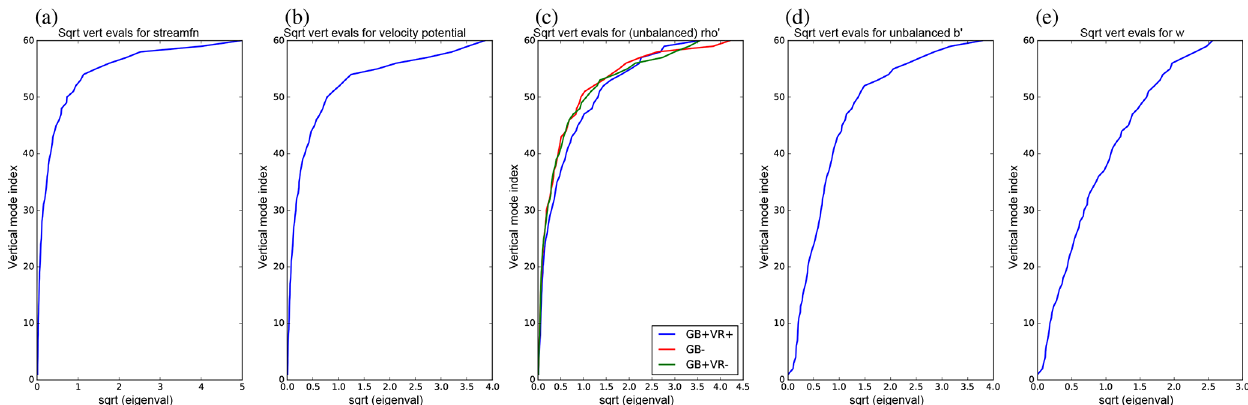
Figure 4. Profiles of the square root of the vertical eigenvalues for the five control parameters as a function of vertical mode index ν : (a) δ ψ , ˜ ρ (cid:48) u , (d) δ b (cid:48) u , and (e) δ w . The blue lines are for the experiment described in the text – namely GB and VR switched on. In (b) δ χ vp , (c) δ panel (c) the red line is for the experiment with GB (and hence VR) switched off, and the green line is for the experiment with GB switched on and VR switched off. In the other panels, all experiments yield the same profiles.